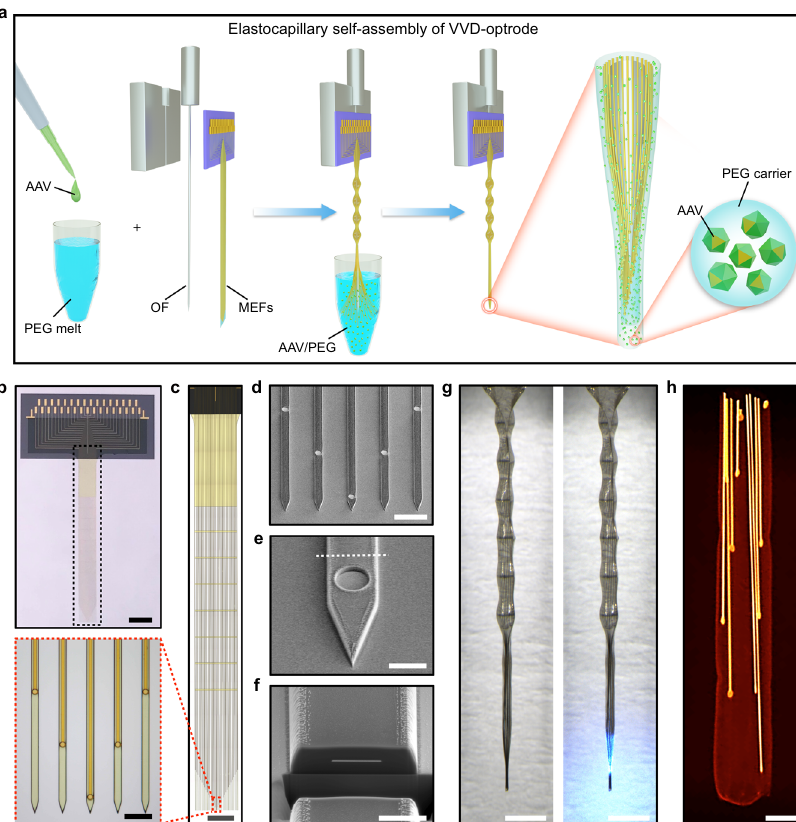
Fig. 1 Self-assembled multifunctional VVD-optrodes. a Schematics of the elastocapillary self-assembly process of a VVD-optrode. b A MEF array. Scale bar, 2 mm. c Zoom-in views of the plane-mesh- fi lamentous structure in the black dashed box in ( b ). Scale bar, 1 mm and 50 μ m (magni fi ed view). d SEM image (tilted at 45°) of the microelectrode fi laments of a MEF array. Scale bar, 50 μ m. e Enlarged SEM image (tilted at 45°) of a microelectrode fi lament. Scale bar, 10 μ m. f Focused ion beam-polished cross-section along the white dashed line in ( e ). Scale bar, 5 μ m. g A self-assembled VVD-optrode without (left) and with blue light illumination (right), respectively. Scale bar, 1 mm. h False-color micro-CT image of a self-assembled probe. Scale bar, 50 μ